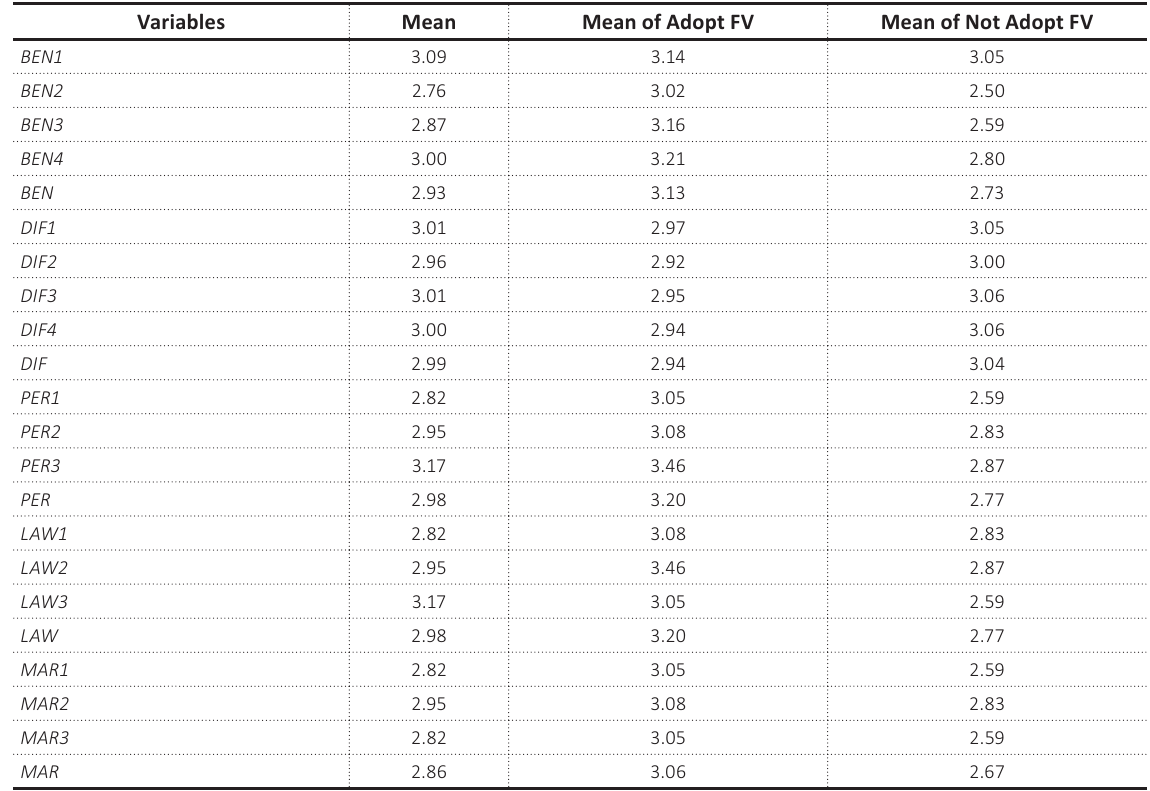
Table A2. Descriptive statistics